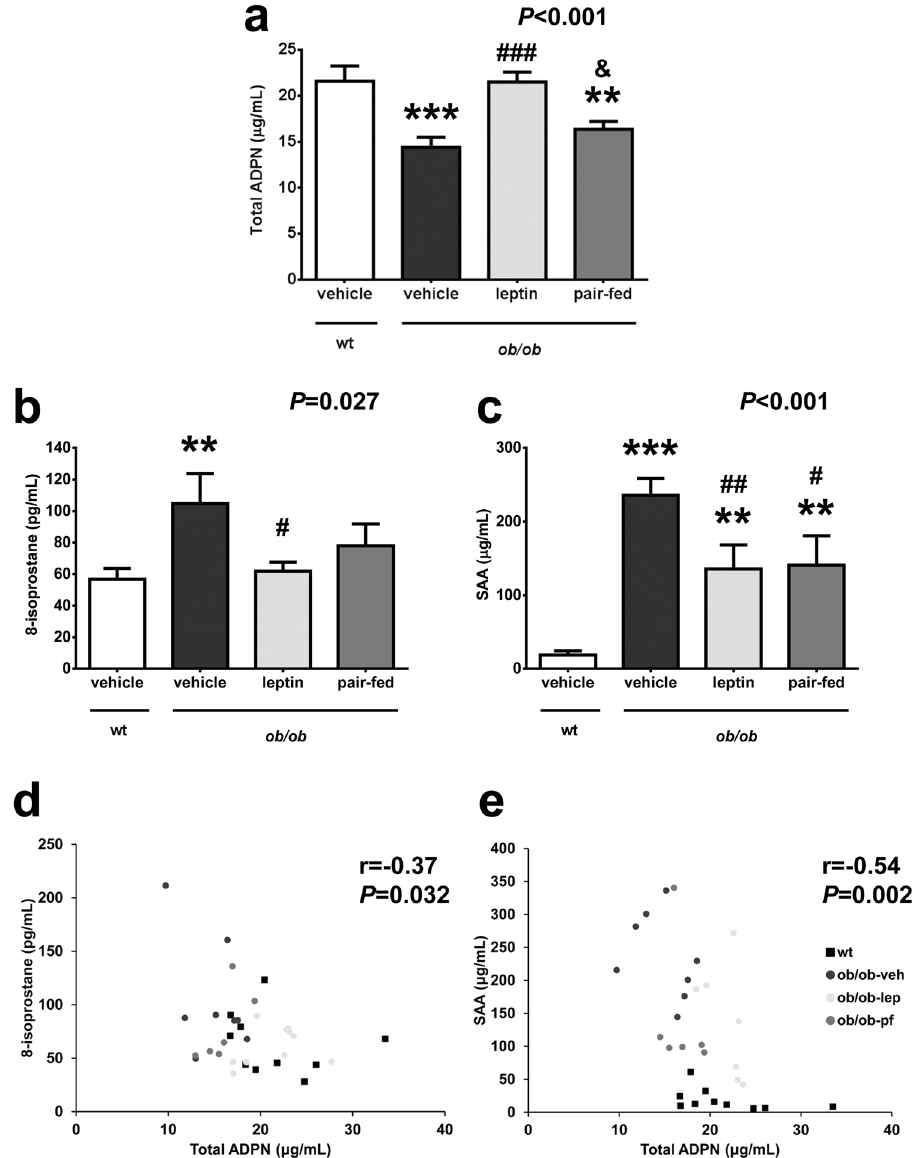
Figure 1. Leptin replacement increases total adiponectin (ADPN) concentrations, which were reduced in ob/ob mice, reducing systemic inflammation and oxidative stress. Serum levels of total adiponectin ( a ), 8-isoprostane ( b ) and serum amyloid A (SAA) ( c ) in wild type (wt) and ob/ob mice receiving vehicle, leptin or receiving vehicle and pair-fed to the leptin group. Data presented as mean ± SEM. Differences between groups were analyzed by one way ANOVA followed by LSD test. ** P < 0.01 and *** P < 0.001 vs wt; # P < 0.05, ## P < 0.01 and ### P < 0.001 vs ob/ob treated with vehicle; & P < 0.05 vs ob/ob treated with leptin. Scatter diagrams showing the negative correlation found between the circulating concentrations of total adiponectin and the levels of 8-isoprostane ( d ) and SAA ( e ). Pearson’s correlation coefficient and P values are indicated. n = 6–10 per